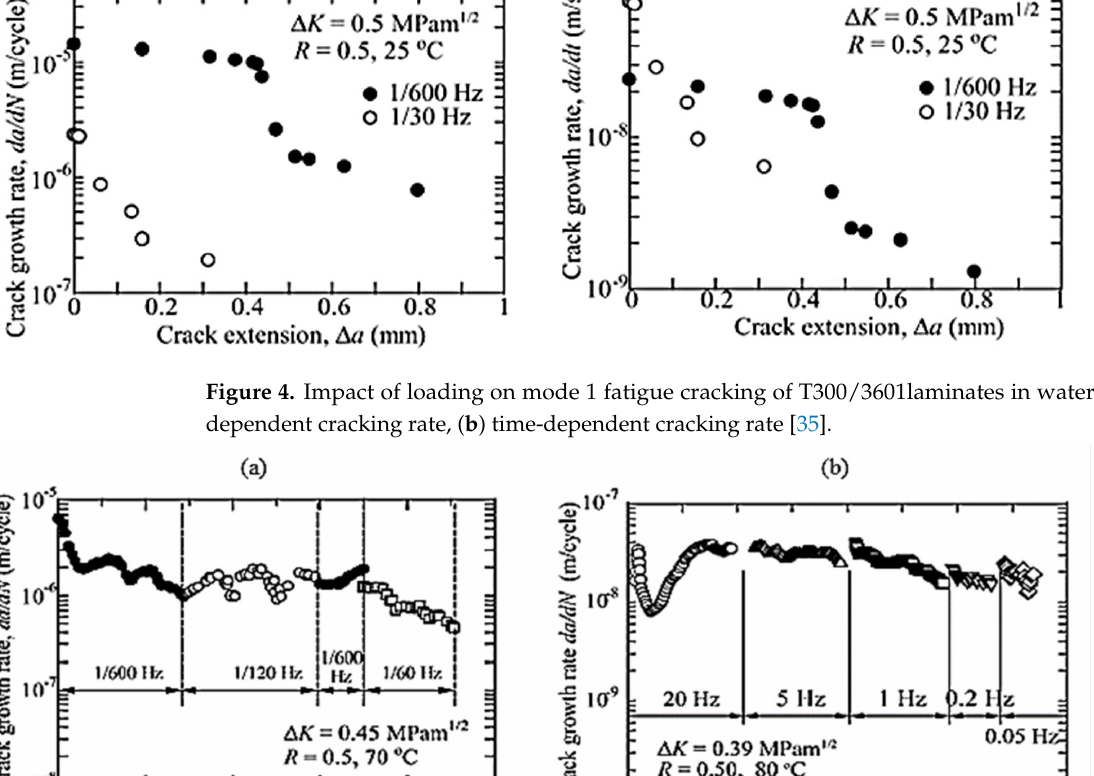
Figure 5. Impact of loading frequency on mode I fatigue of T300/3601 laminates in air ( a ) 1/600–160 Hz, ( b ) 0.05–20 Hz [35].